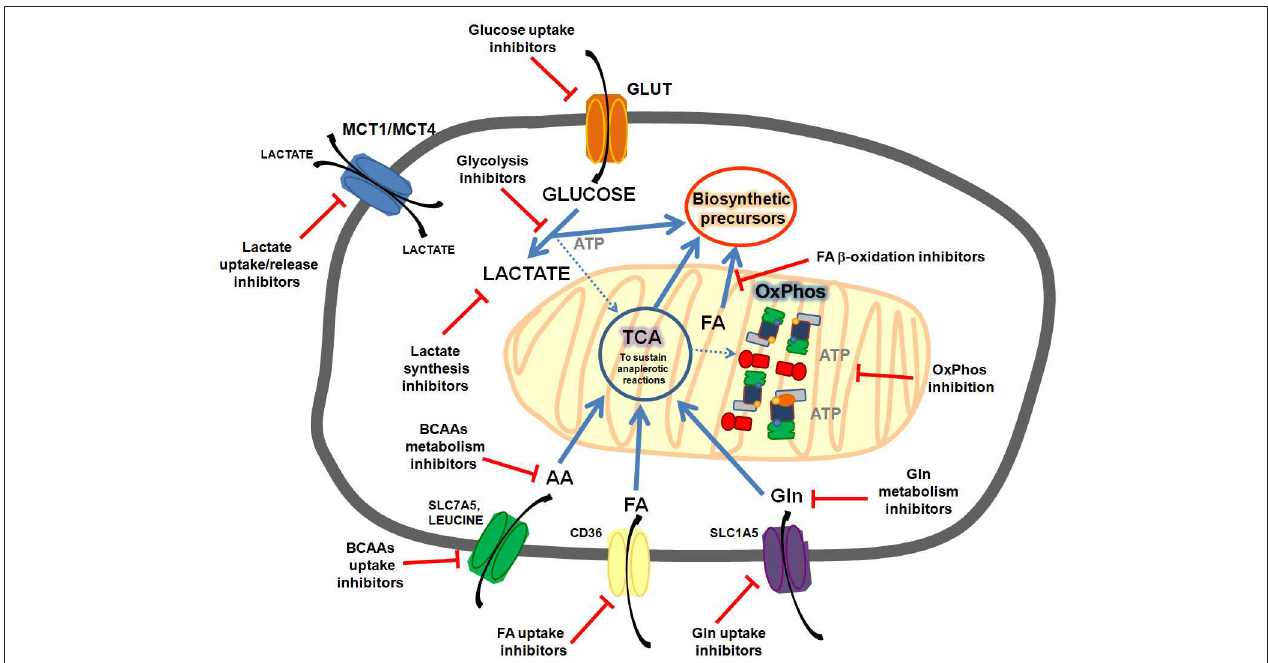
FIGURE 1 | Common metabolic features targeted in cancer cells. Cancer cells could present enhanced glycolisis and lactate release, enhanced FA (fatty acids) synthesis, uptake and oxidation; enhanced OxPhos activity, enhanced glutamine uptake and metabolism, enhanced branched amino acids (BCAAs) uptake and oxidation, etc. Targeting these pathways could sensitize cancer cells to